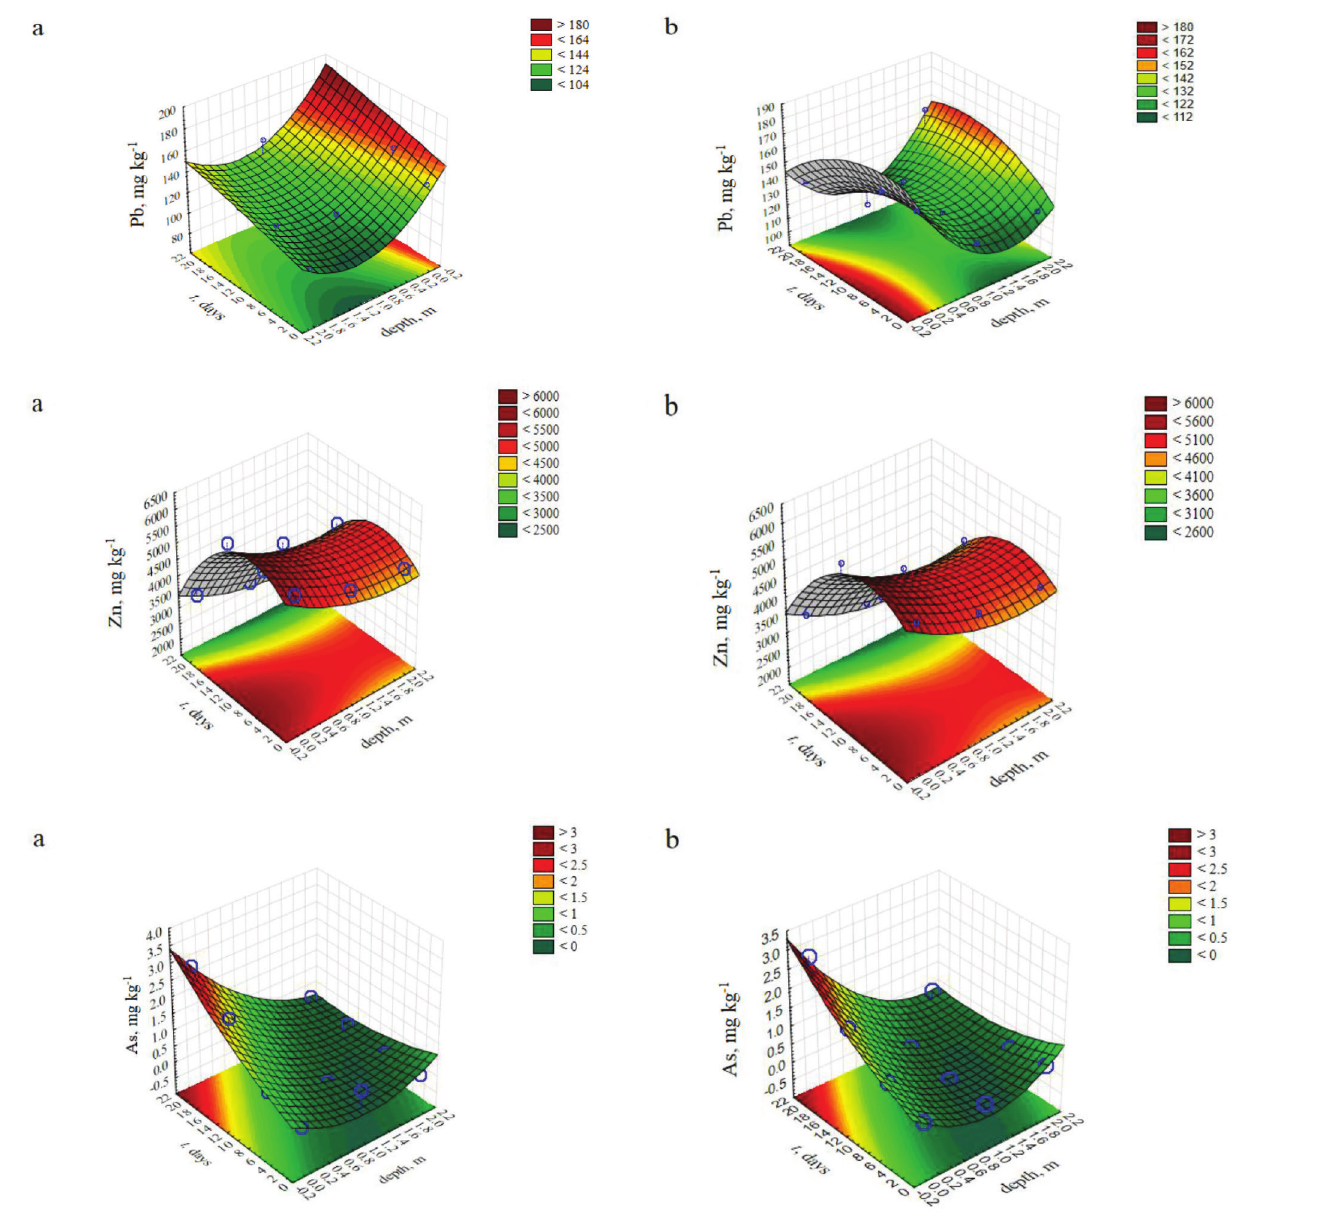
Fig. 3 – Changes in Cd, Cu, Mn, Ni, Pb, Zn, and As concentrations with time and depth during: (a) leaching test in deionized water, and (b) leaching test in acid